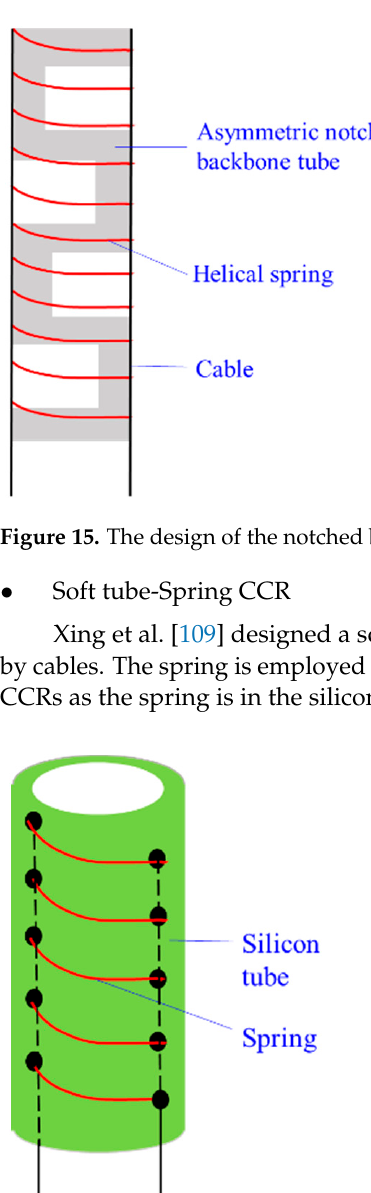
12 of 27 Figure 14. Three designs of the backbone-concentric-tube CCRs [108]. • Backbone-Bellow CCR The nickel bellow has much higher rigidity than a polyamide bellow. The torsional rigidity of the backbone CCRs is relatively low. Xu et al. introduced a backbone-bellow CCR, whose nickel bellows wrap outside of the backbones [43]. The torsional rigidity of the backbone CCR is enhanced more than four times when a nickel bellow is integrated, and the bending capabilities are not compromised. •